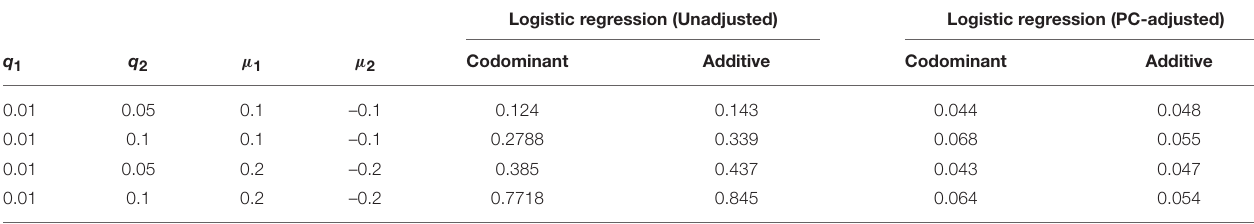
TABLE 5 | Estimated false positive rates before and after adjustment using the top five principal components for the rare variant case. Logistic regression (Unadjusted) Logistic regression